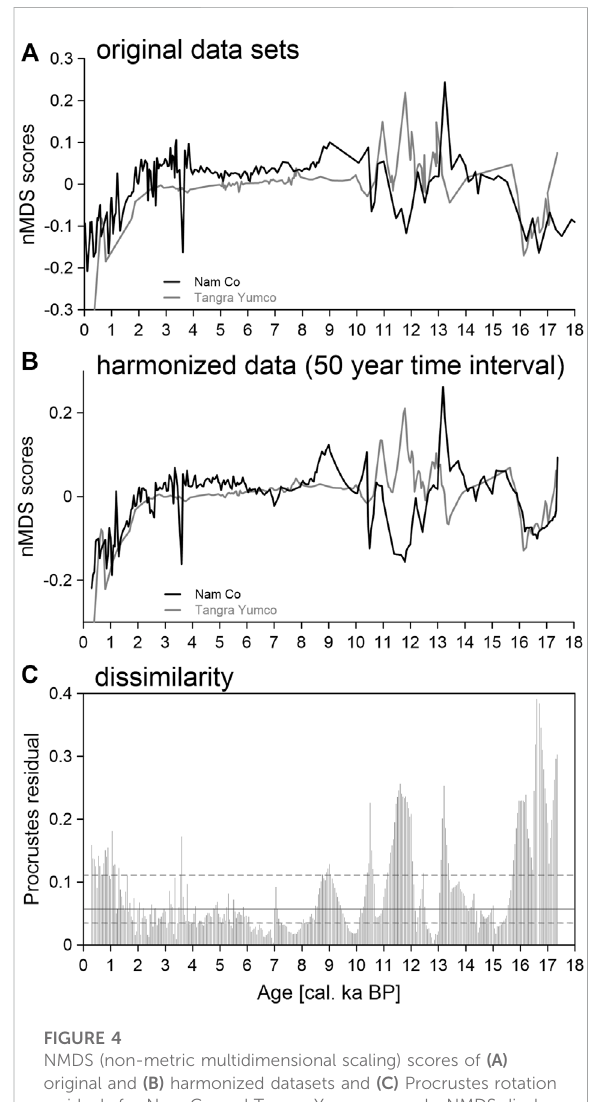
FIGURE 4 NMDS (non-metric multidimensional scaling) scores of (A) original and (B) harmonized datasets and (C) Procrustes rotation residuals for Nam Co and Tangra Yumco records. NMDS display patterns of variation within each record. The amplitude of Procrustes residuals re fl ects the degree of similarity/dissimilarity between the Nam Co and the Tangra Yumco record. Solid horizontal line shows mean deviation between records, dashed horizontal lines show the fi rst and third quartile. Dissimilarity between both records is observed for the periods 17.4 – 15.8, 13.4 – 13, 12 – 11.1, 10.5, and 1.1 – 0.3 cal. ka